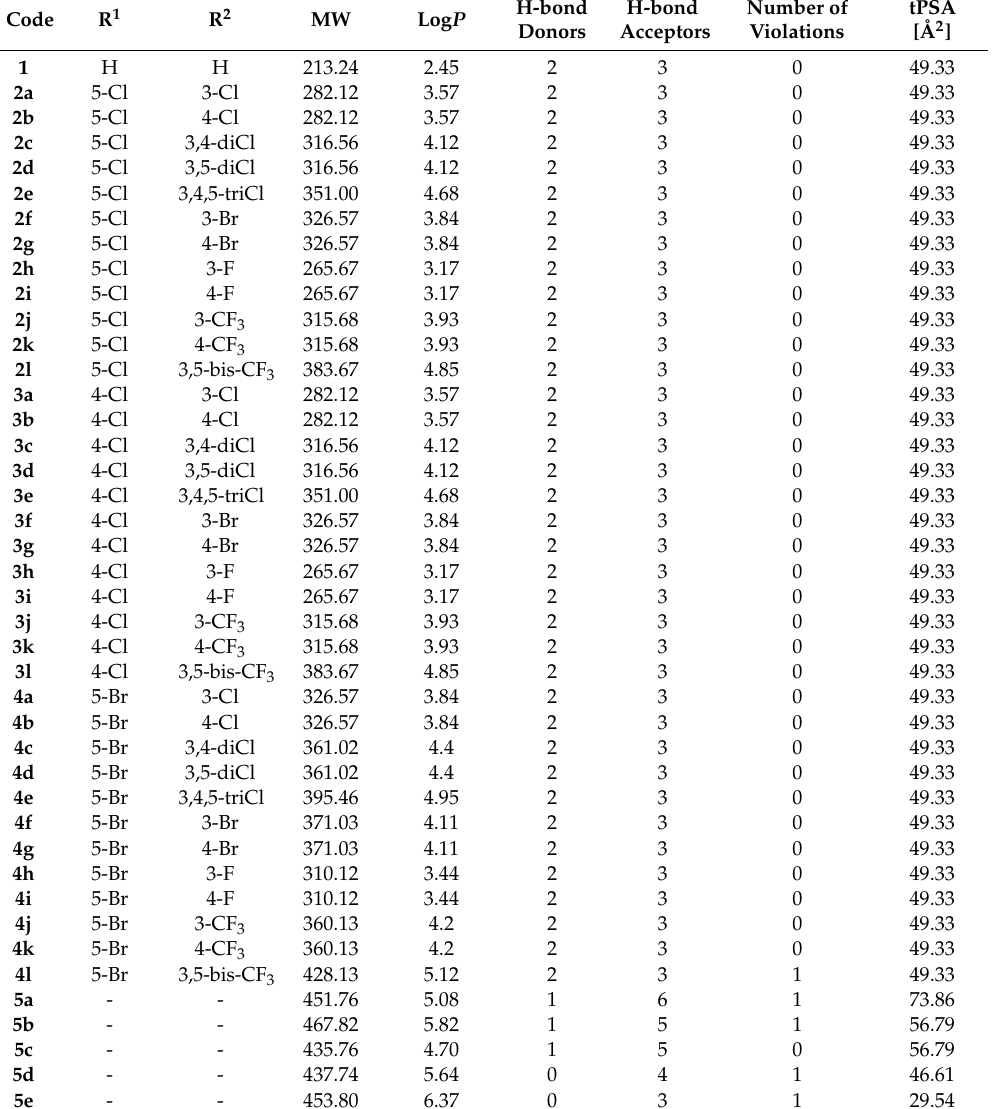
Table 3. Lipinski’s rule of five parameters and PSA values of the derivatives 1 -